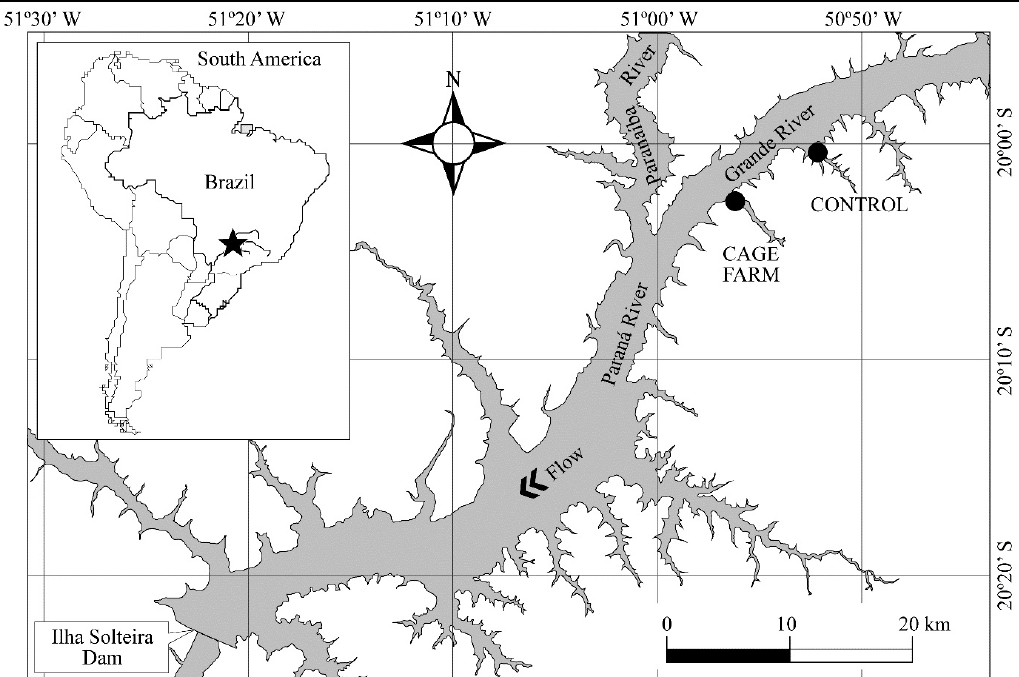
Figure 1. The study area showing the Ilha Solteira Reservoir, with sampled areas in the Grande River, São Paulo, Brazil. Source: Kliemann et al.